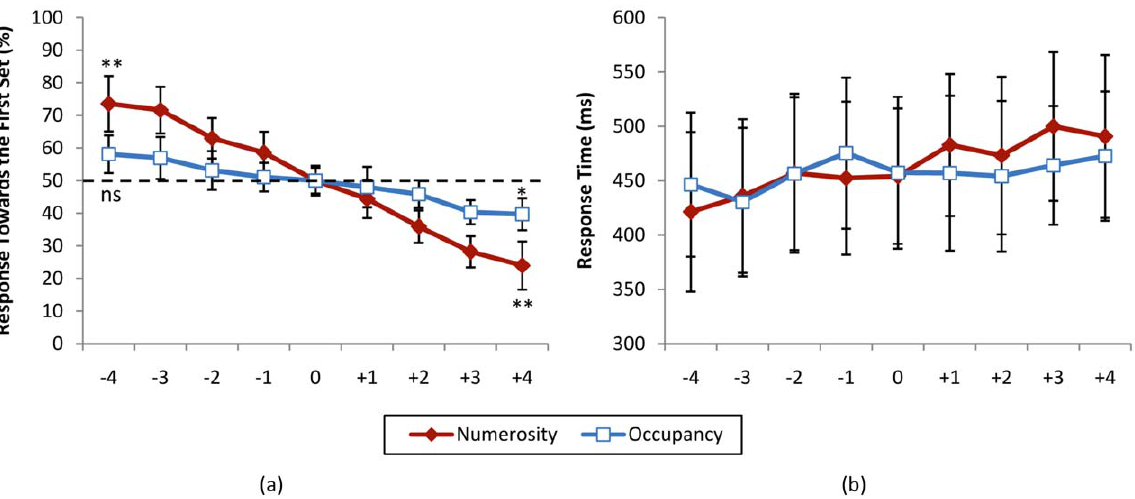
Figure 5. Psychometric function for the control experiment. (a) Percentage response towards the first set and (b) response time for numerosity ( n 1 ? n 2 , a total,1 = a total,2 ) and occupancy ( n 1 = n 2 , a total,1 ? a total,2 ) judgement phases. Horizontal axis shows different levels of comparison ( n 2 2 n 1 for numerosity and a total,2 2 a total,1 for occupancy judgement phase). ** p , 0.005, * p , 0.025, ns not significant. Error bars reflect one standard deviation.